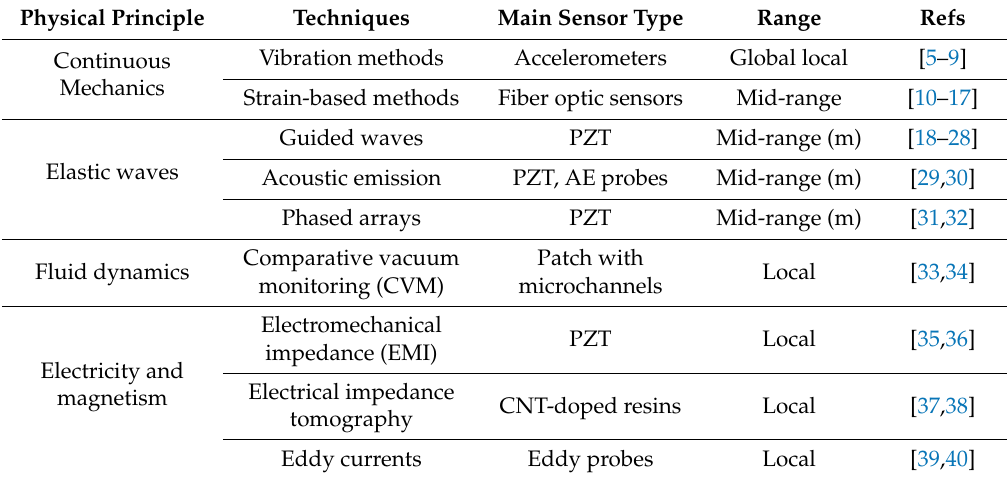
Table 1. Classification of Structural Health Monitoring (SHM) Technologies.